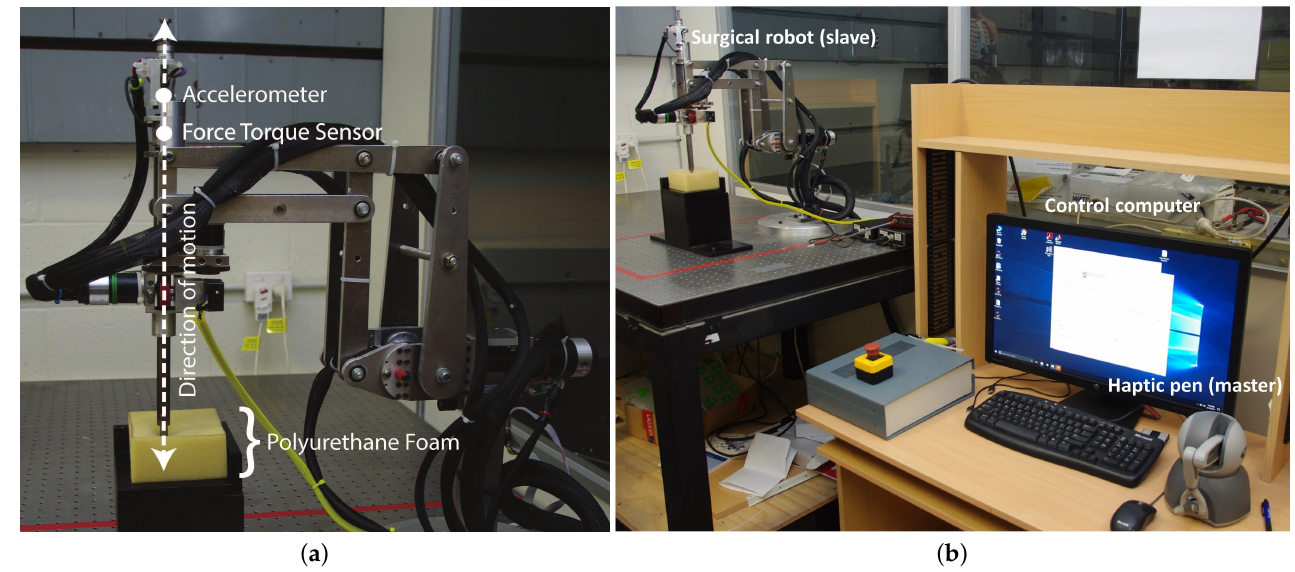
Figure 5. Experimental research facility. ( a ) Surgical robot (slave) in contact with the polyurethane foam. ( b ) Full experimental teleoperated system featuring surgical robot (slave), haptic pen (master), and control